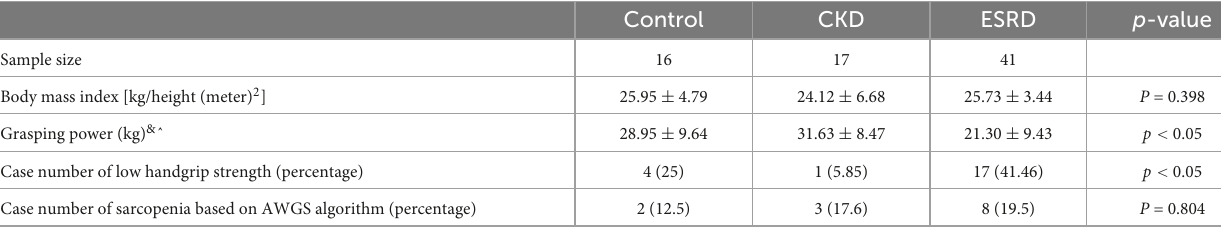
TABLE 2 Incidence of low handgrip strength and sarcopenia by group.